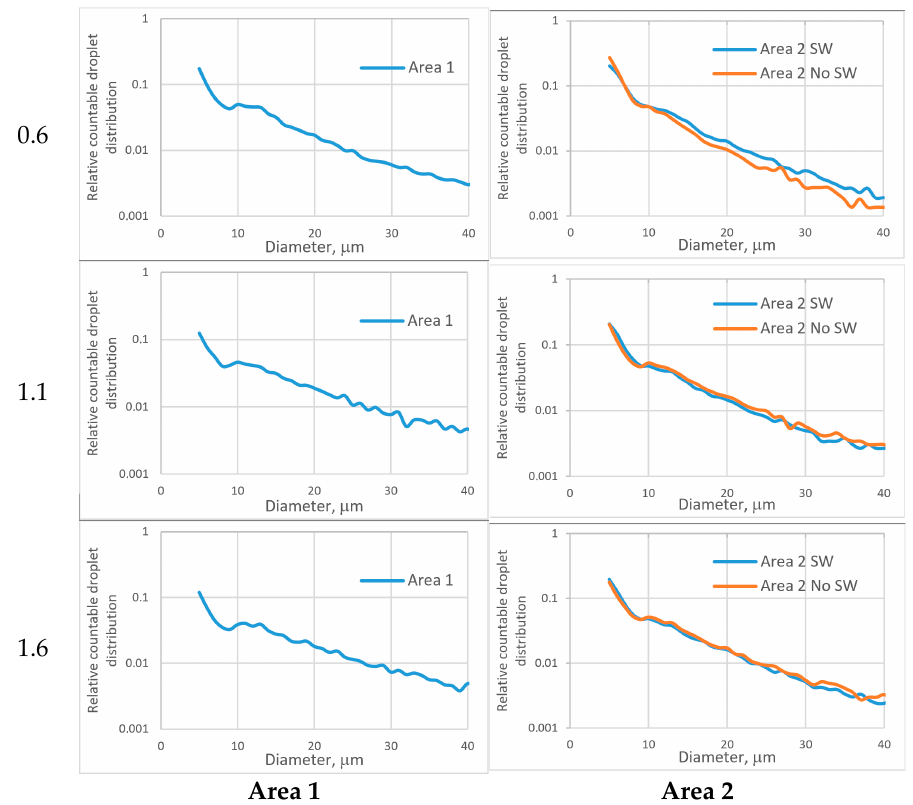
Figure A3. Relative countable droplet distribution by diameters, gas flow Mach number M = 3. The left column shown water injection pressure p l , MPa.